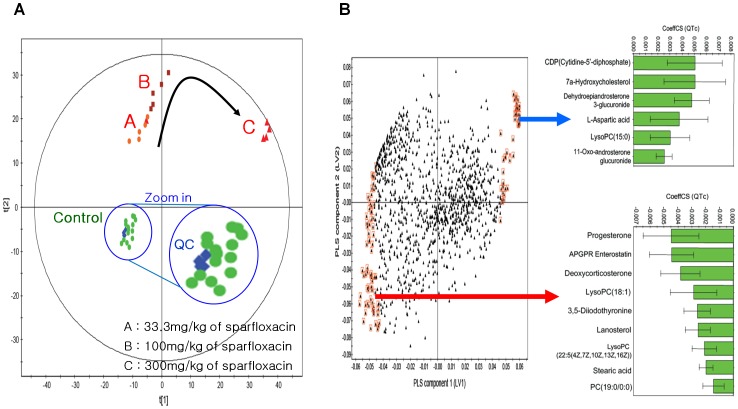
PCA and PLS modelling of plasma LC–MS metabolic data for predicting the drug-induced QT prolongation of sparfloxacin.(A) PCA score plot (t[1] vs. t[2]) obtained from guinea pig plasma samples. Obviously separated clustering of dose groups and the control group was shown by PCA; in addition, dose-dependent metabolomic modification was detected. (B) Loading plot for the above PLS model in which each point represents a metabolic feature detected from plasma LC–MS data and is plotted as its respective coefficient from PLS component 1 vs. its coefficient from PLS component 2. The arrow indicates a positive relationship with the QTc. Metabolite variables with larger coefficient values (positive or negative) have a stronger correlation with the QTc (marked by red boxes; VIP>1.5) and were used to build the PLS model for predicting cardiovascular toxicity. The inset green bar plot shows the correlation coefficients for the key identified metabolites.